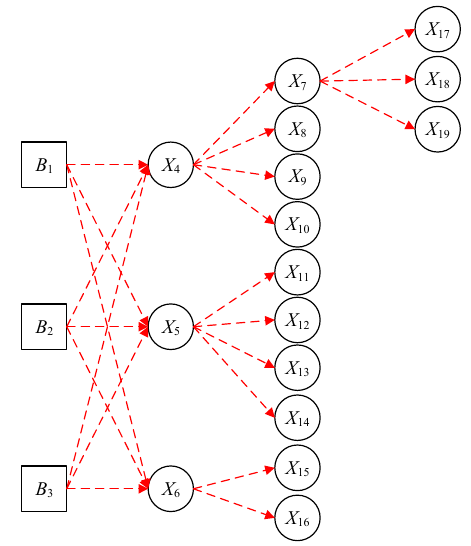
Figure 6. Shale-gas sweet-spot evaluation model with the DUCG.